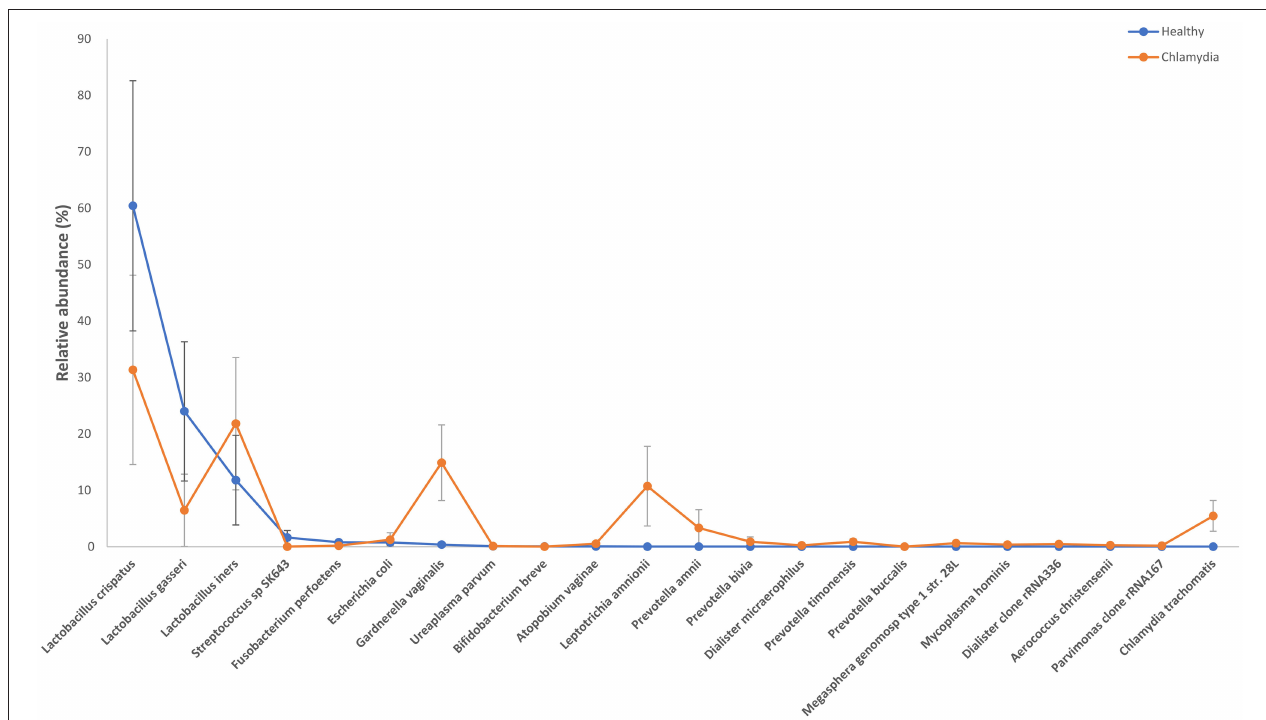
FIGURE 1 | Relative abundance of the observed species in cervical samples from C. trachomatis positive women and healthy controls. All values are mean ± standard deviation. Kruskal–Wallis test with Benjamin–Hochberg false discovery rate (FDR) correction was used for taxa level comparisons between chlamydia-positive women and healthy